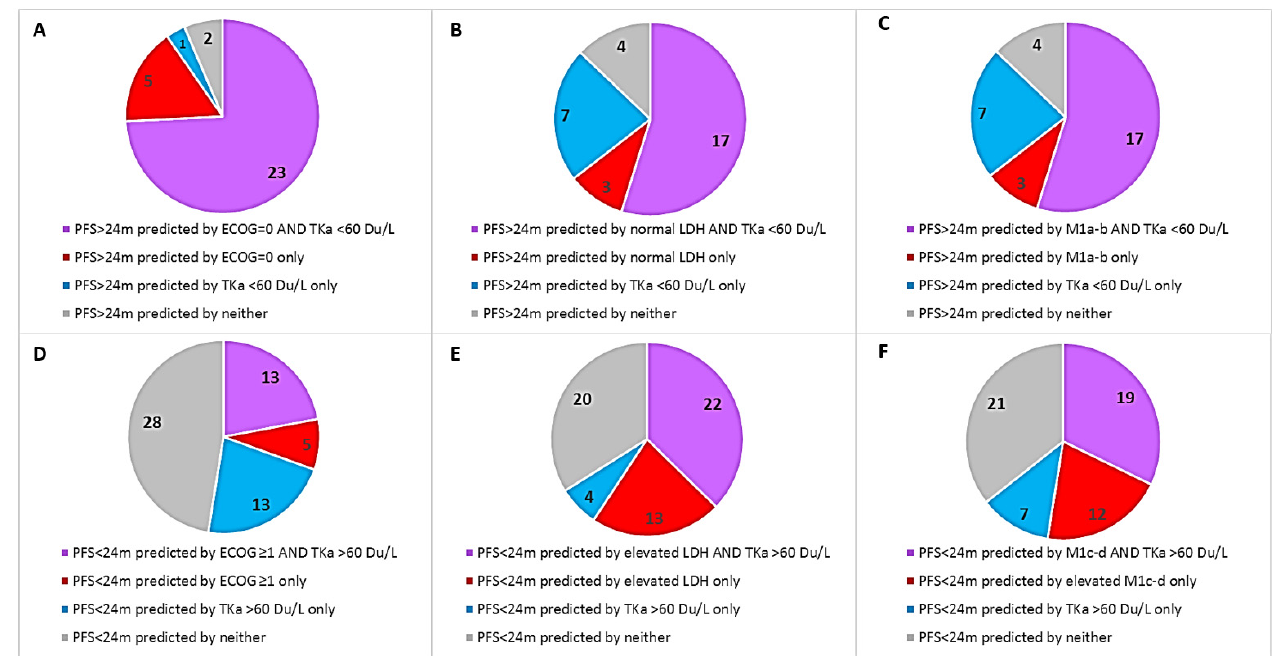
Figure 3. Pie charts that show the number of patients with longer (>24 months, ( A – C )) or shorter (<24 months, ( D – F )) progression-free survival (PFS). Each pie chart shows if longer or shorter PFS was correctly predicted by the TKa level together with one other baseline variable (ECOG, LDH, or M stage.) For example ( B ) shows that in 17 patients, long PFS was predicted by both low TKa and normal LDH at baseline (correctly predicted by both variables, purple), in 3 patients long PFS was predicted only by normal LDH, as TKa was elevated (correctly predicted only by LDH, red), in 7 patients long PFS was predicated only by low TKa, as LDH level was elevated (correctly predicted only by TKa, blue), and in 4 patients long PFS was predicted by neither variable, as both LDH and TKa levels were high (correctly predicted by none, gray). Table 4. Cox regressions for survival in metastatic melanoma patients treated with immune check- point inhibitors.